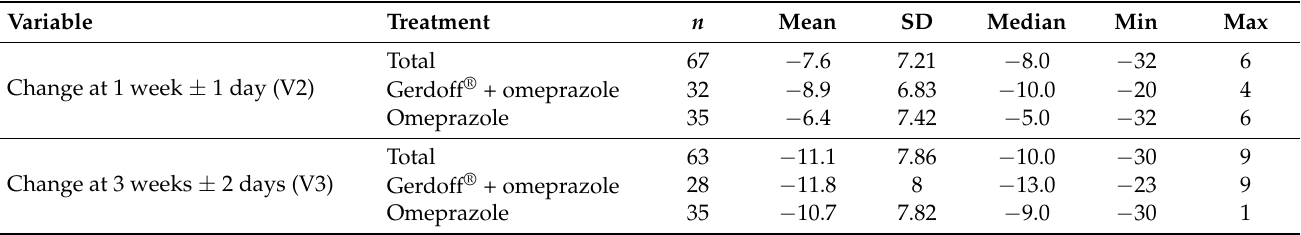
Table 5. Summary of changes in the total RSI score from baseline to any intermediate time point during the 6-week treatment